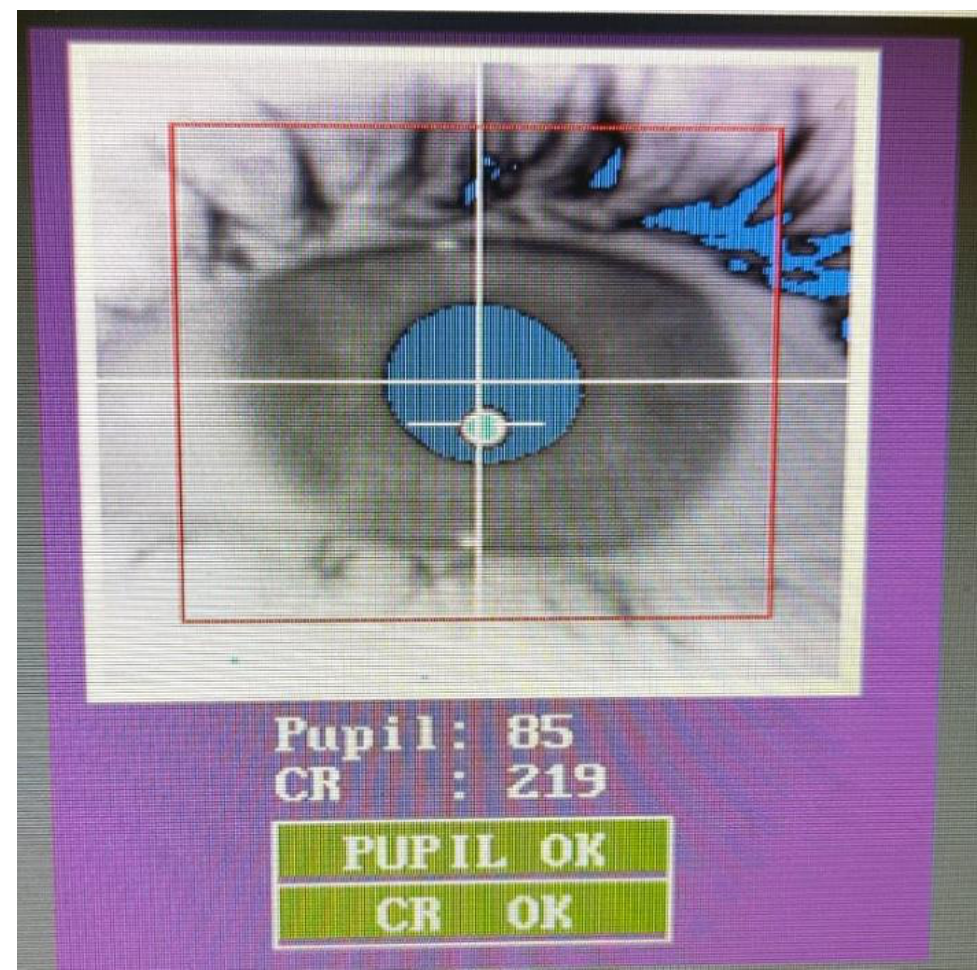
Figure 7. Example of the user view from EyeLink 1000 Plus eye-tracking system. The pupil is highlighted in blue. The little light-blue dot underneath is the corneal reflection, projected from the eye tracker into the participant’s eye.